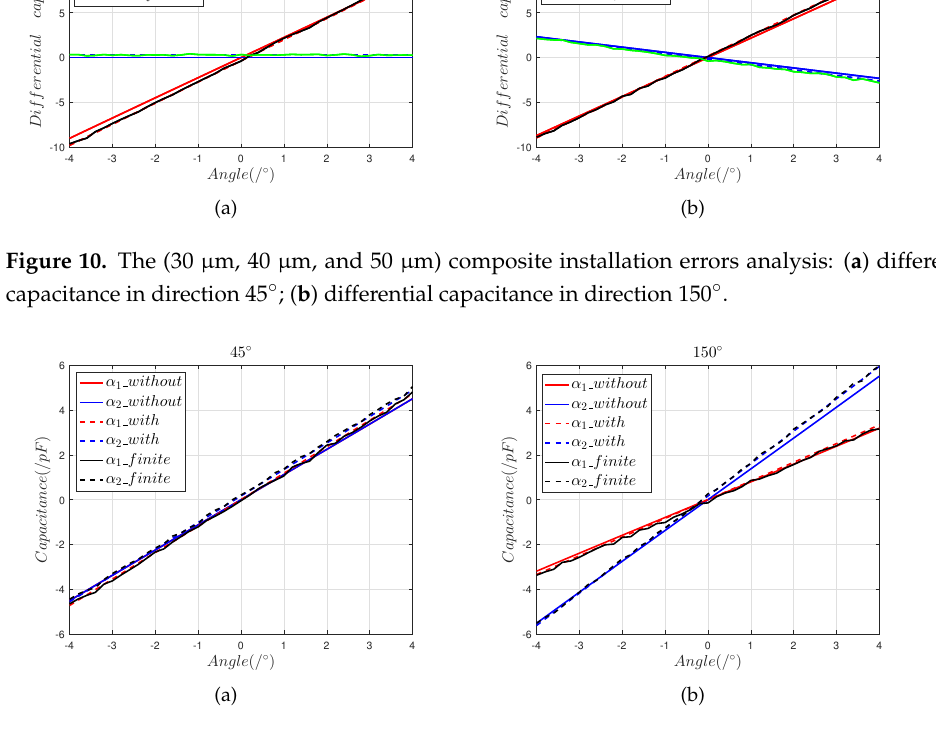
Figure 11. The (30 µ m, 40 µ m, and 50 µ m) composite installation error analysis: ( a ) differential capacitance in the 45° direction; ( b ) differential capacitance in the 150°